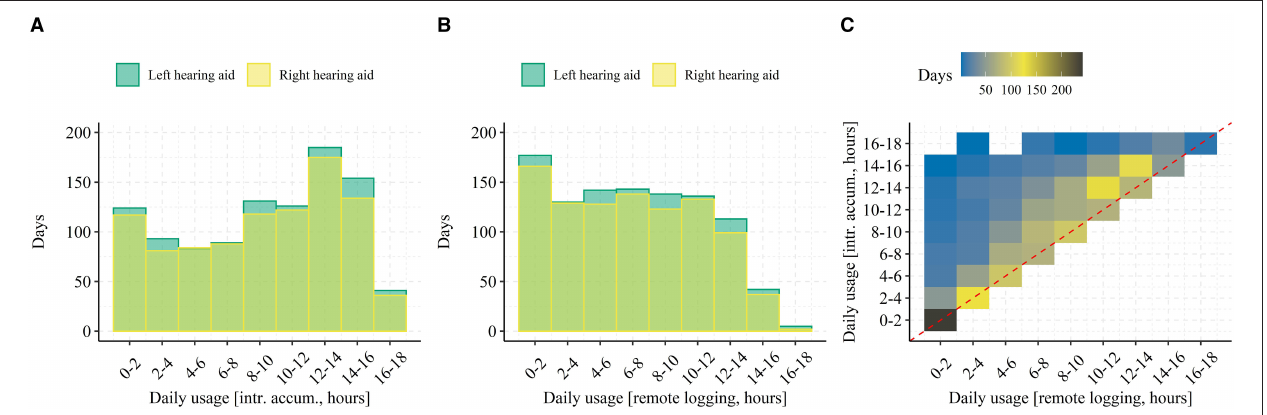
FIGURE 4 | Pooled daily hearing aid usage among all participant days. In (A) , a histogram of daily usage estimated from intrinsic accumulation and pooled among all participants, days, and separated by hearing aid side is shown. In (B) , the same is shown but for daily usage estimate from remote logs. In (C) , the estimated daily usage is shown as a 2D density histogram with the intrinsic accumulation on the y-axis and the connectivity-dependent remote logging on the x-axis. Data falling on the diagonal (red dashed line) represent days with no or < 2h of connectivity issues (i.e., comparable estimation of daily usage from intrinsic accumulation and remote logging).